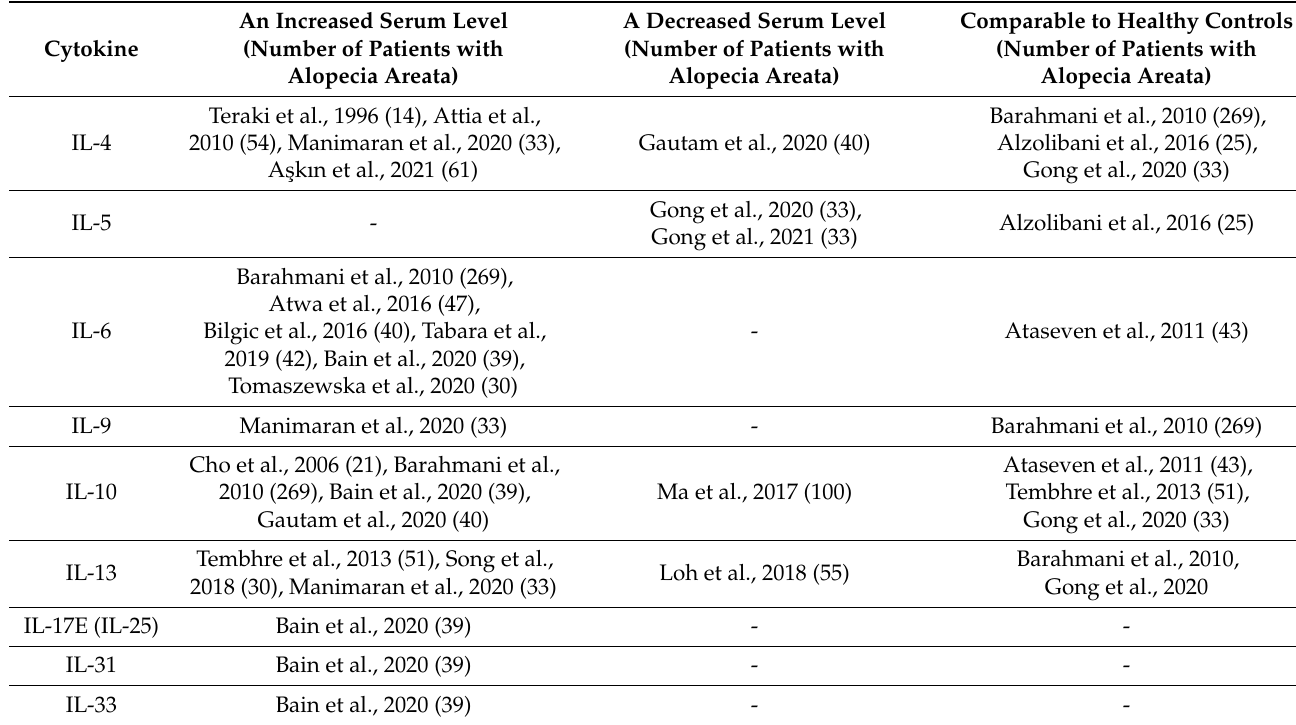
Table 2. Summary of current literature considering the serum Th2 cytokine levels in patients with alopecia areata. An Increased Serum Level Cytokine (Number of Patients with Alopecia Areata)